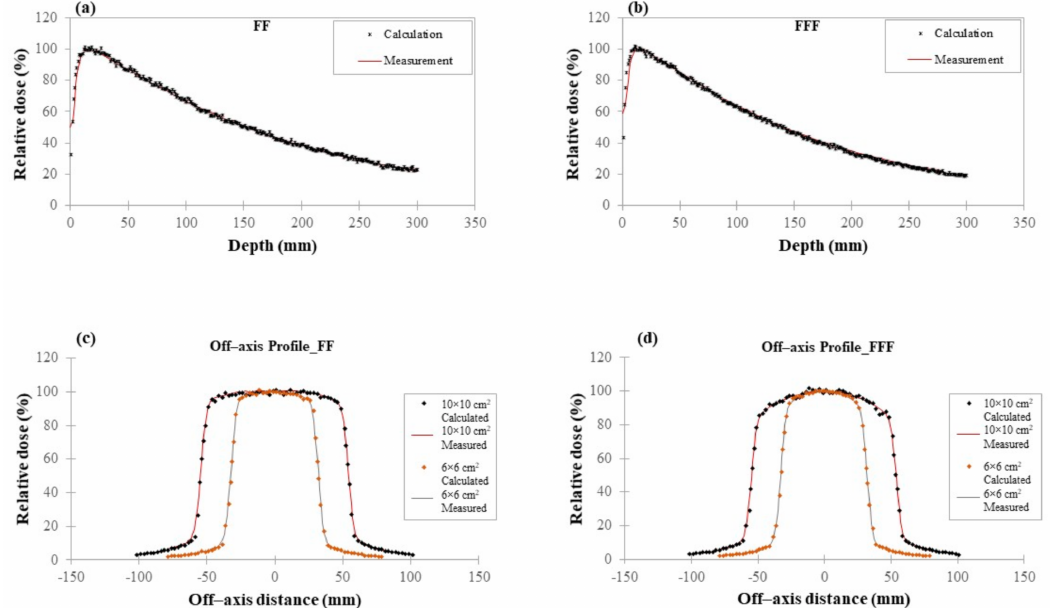
Figure 2. Calculated (MC simulation) and measured (clinical TrueBeam ® platform) relative dosimetric data: ( a ) Calculated and measured PDD comparisons for a FF 10 × 10 cm 2 photon field; ( b ) Calculated and measured PDD comparisons for a FFF 10 × 10 cm 2 photon field; ( c ) Off–axis profiles along left–right (LR) direction at a depth of 10 cm for a 6 × 6 cm 2 and 10 × 10 cm 2 FF photon field; ( d ) Off–axis profiles along LR direction at a depth of 10 cm for a 6 × 6 cm 2 and 10 × 10 cm 2 FFF photon